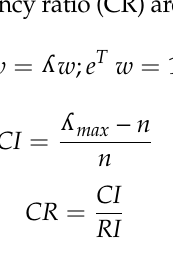
Table 4. Random index (RI) references [64].